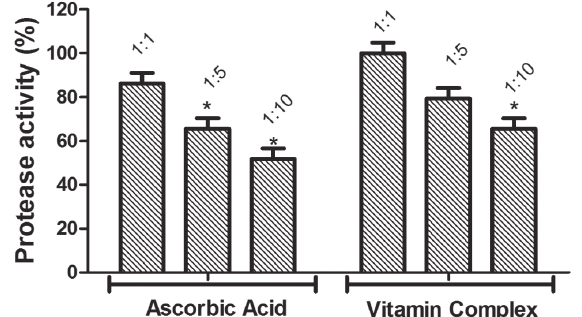
Figure 2 - Vitamins effect on gelatinolytic activity induced by Bothrops atrox venom. The controls average containing only venom was considered as 100%